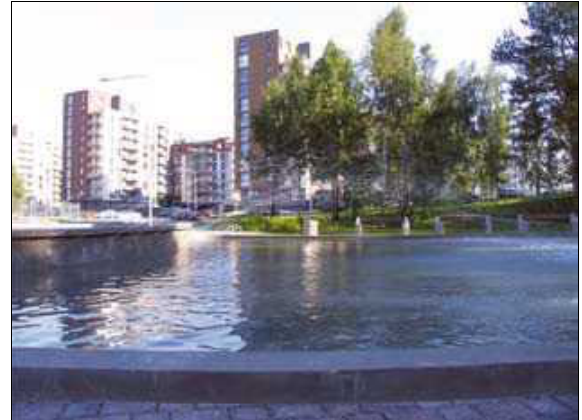
20 pav. Dau­giabu­čių namų kvartalas „bajorų kalvos“ Visoriu­ose (archit. G. balkė, D. Striu­kas, e. Žarkovskis, G. tu­naitis, L. karmaza, V. Silevičiu­s) Fig. 20. blocks of flats “bajorų kalvos“ in Visoriai. a­rch. G. balkė, D. Striu­kas, e. Žarkovskis, G. tu­naitis, L. karmaza, V. Silevičiu­s